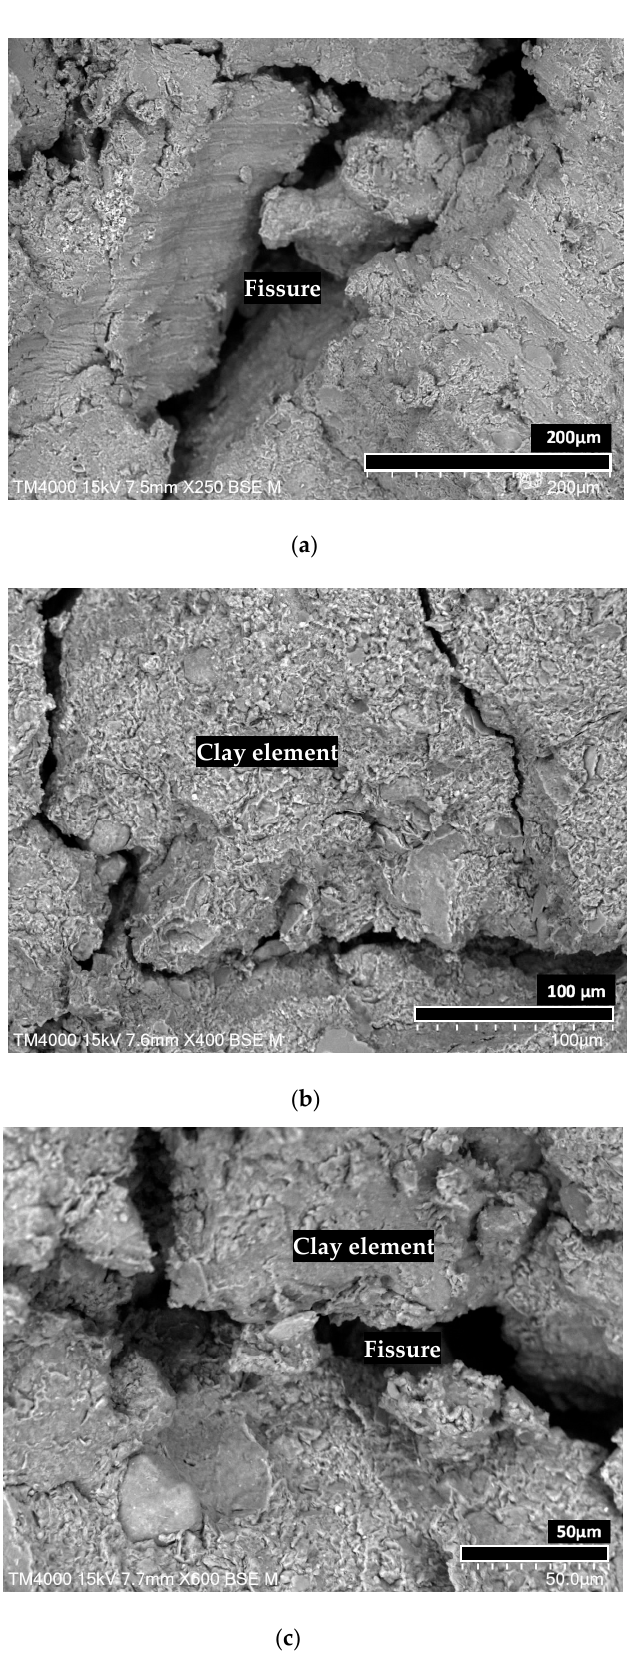
Figure 2. SEM micrographs at small to medium magnification of Paola Doce fissured clay (( a ), 250 × ; ( b ), 400 × ; ( c ), 600 ×